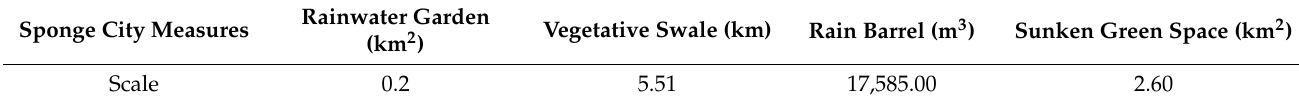
Table 3. Implementation area of sponge city measures in